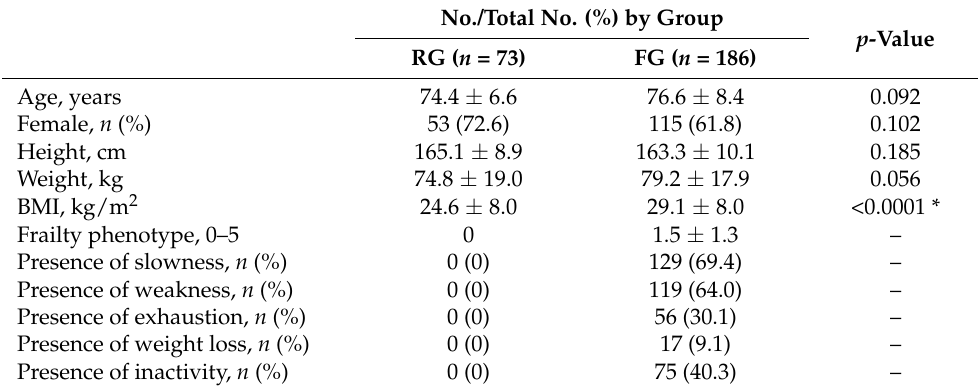
Table 2. Demographics and frailty phenotypes for robust group (RG) and pre-frail/frail group (FG).